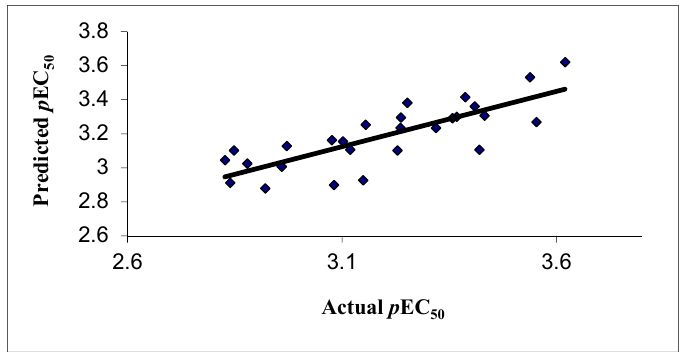
Figure 1. Contribution chart of descriptors in 2D QSAR model.